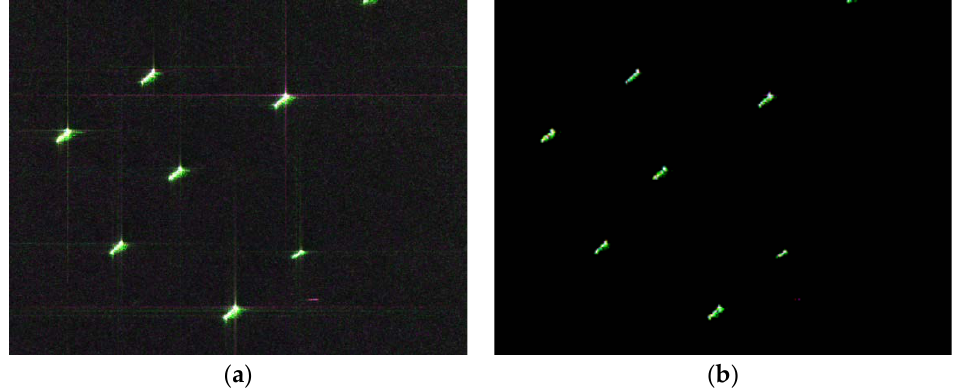
Figure 9. Processing results full-polarization GF-3 image of the Indian Ocean. ( a ) Full-polarization pseudo-color GF-3 image; ( b ) reconstructed full-polarization pseudo-color image of (a) through the proposed method.